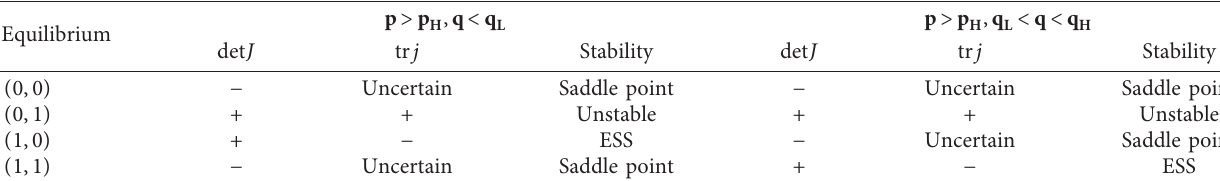
Table 5: Equilibrium point local stability.